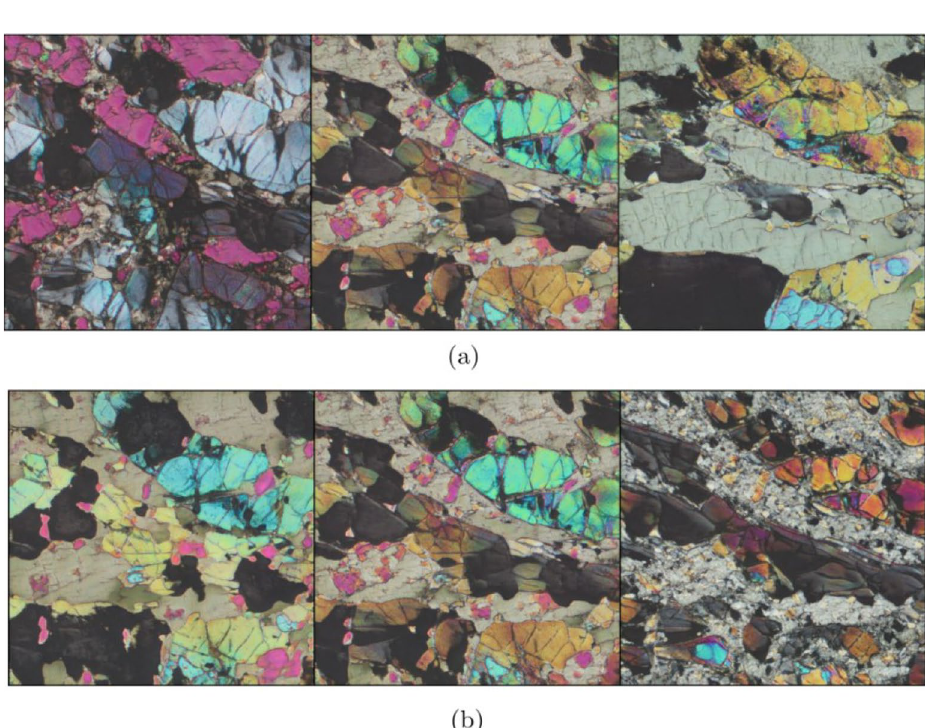
Figure 10. Feature Extraction of important vectors in the model, the same seed, 168,947, in the center is changed ( a ) modifying colors of the minerals and ( b ) changing the percentage of matrix in the thin